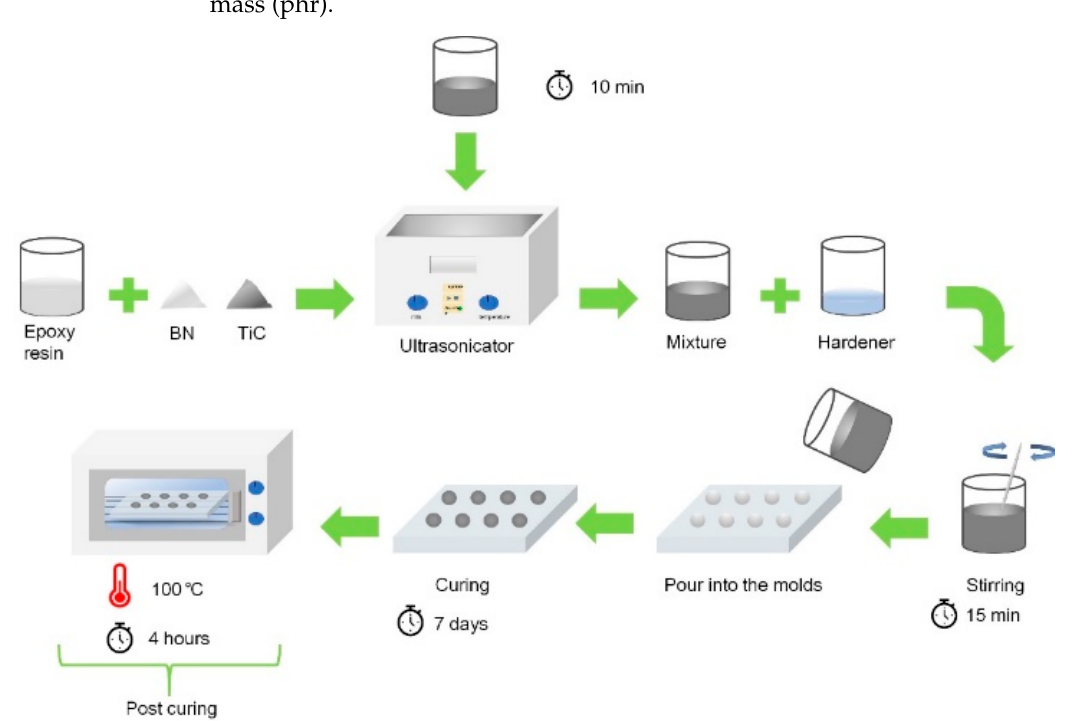
Figure 1. Schematic representation of the nanocomposites’ fabrication procedure.